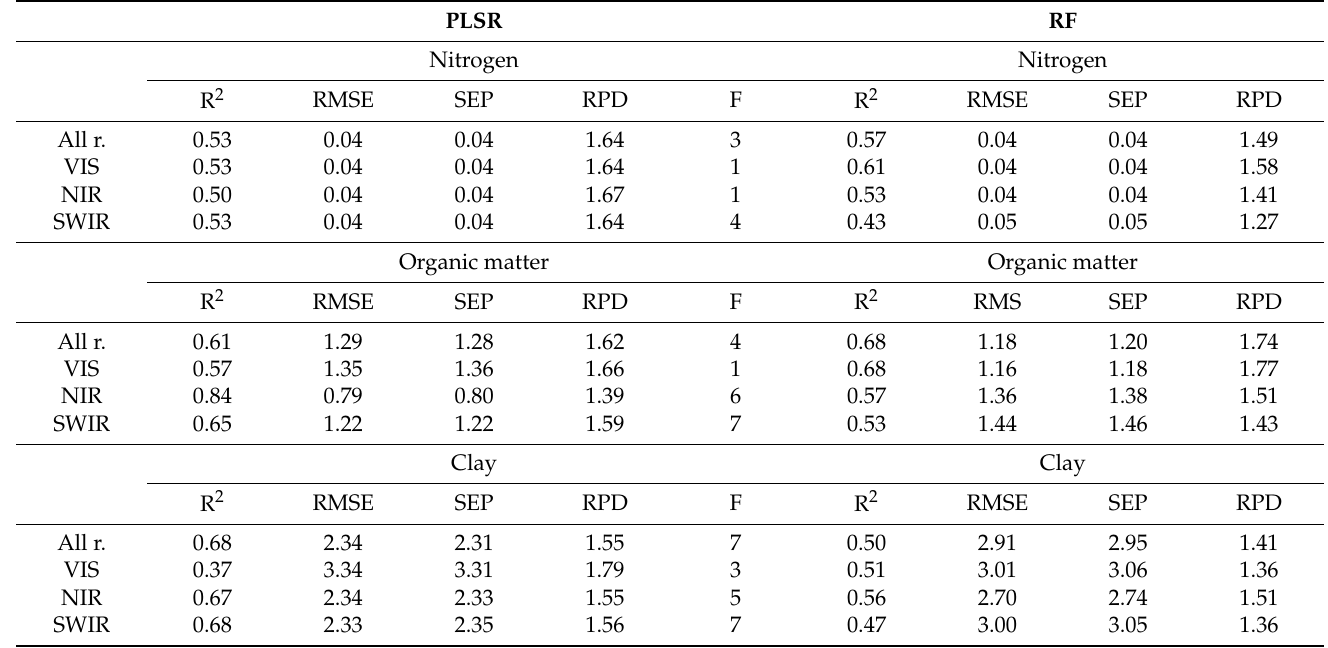
R 2 (coefficient of determination); RMSE (root-mean-square error); SEP (standard error); SD (stand- ard error of reference data); RPD (residual prediction deviation); F (Number of model factors).